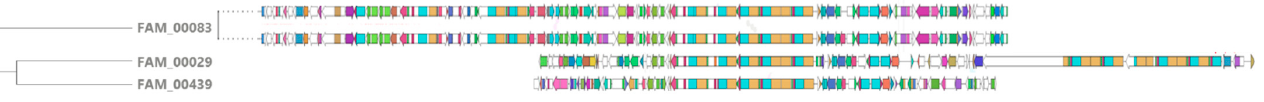
Figure 9. CORASON phylogenetic tree of the three Gene Cluster Families (GCF) in which sandra- mycin BGC has been classified. FAM_00439: sandramycin BGC from Kribbella sp. CA-293567; FAM_0083: sandramycin BGC from K. sandramycini ; FAM_00029: sandramycin BGC from Kribbella quitaiheensis SPB151. The BGCs have been manually centered in the NRPS genes for a better visual-